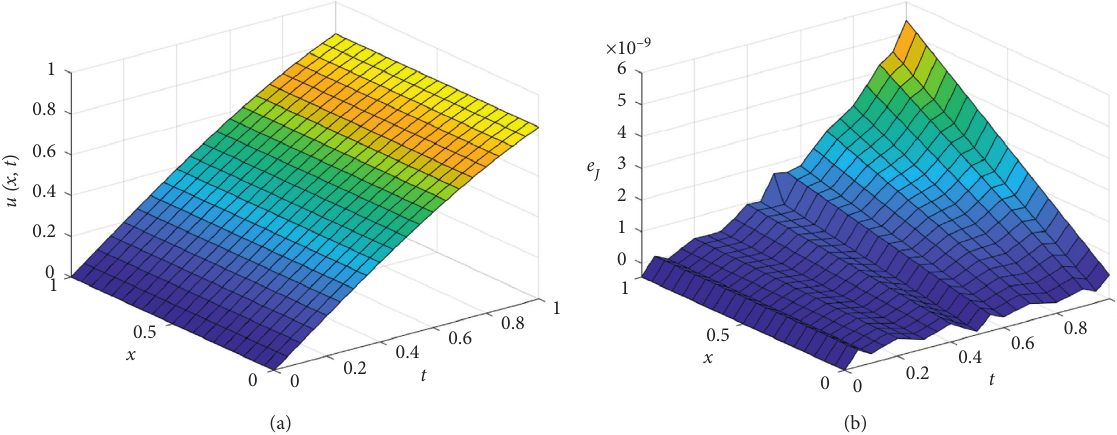
Figure 4: The plots of the approximate solution and the absolute error taking r � 7 and J � 1 for Example 3.